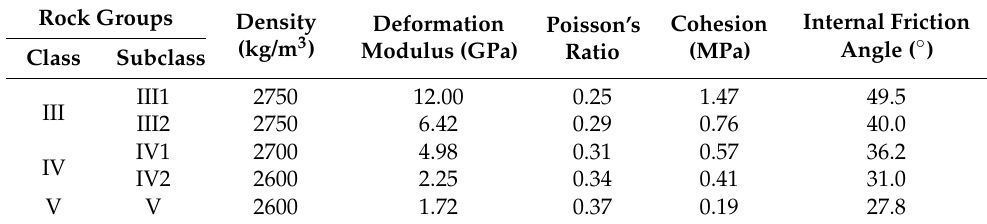
Table 6. Rock parameters used for numerical simulation. Rock Groups